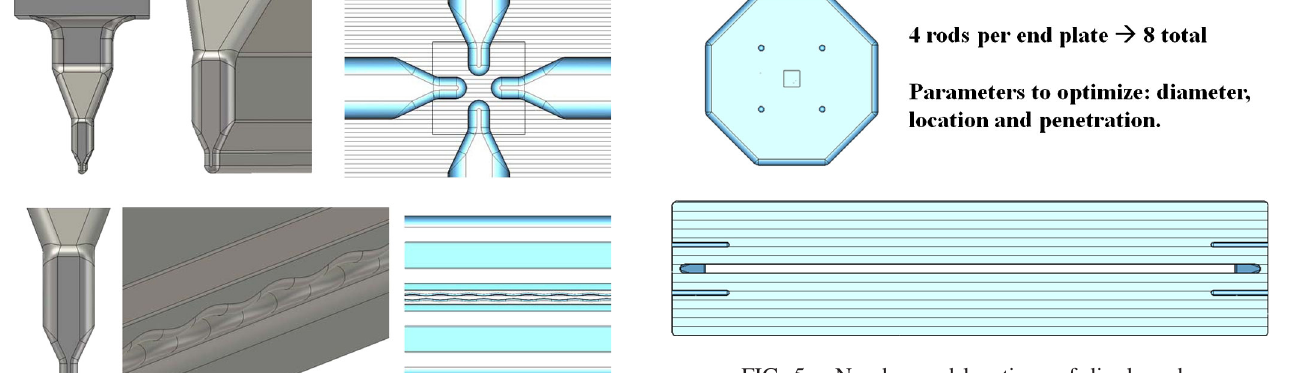
FIG. 5. Number and locations of dipole